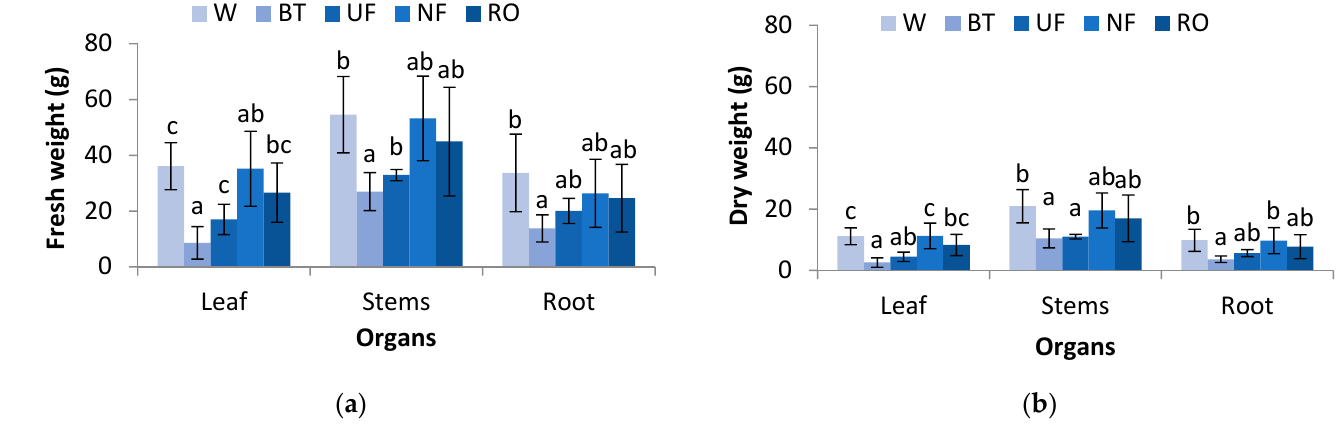
Figure 1. Variation of fresh and dry weight of Sesbania bispinosa plants irrigated by TTE. ( a ) Variation of fresh weight of Sesbania bispinosa plants; and ( b ) variation of dry weight of Sesbania bispinosa plants. W: well water; BT: Biological Treatment; UF: Ultrafiltration; NF: Nanofiltration; and RO: Reverse Osmosis. The means of three observations followed by the different letters in each organ are significantly different according to Tukey’s test at the level of p < 0.05.